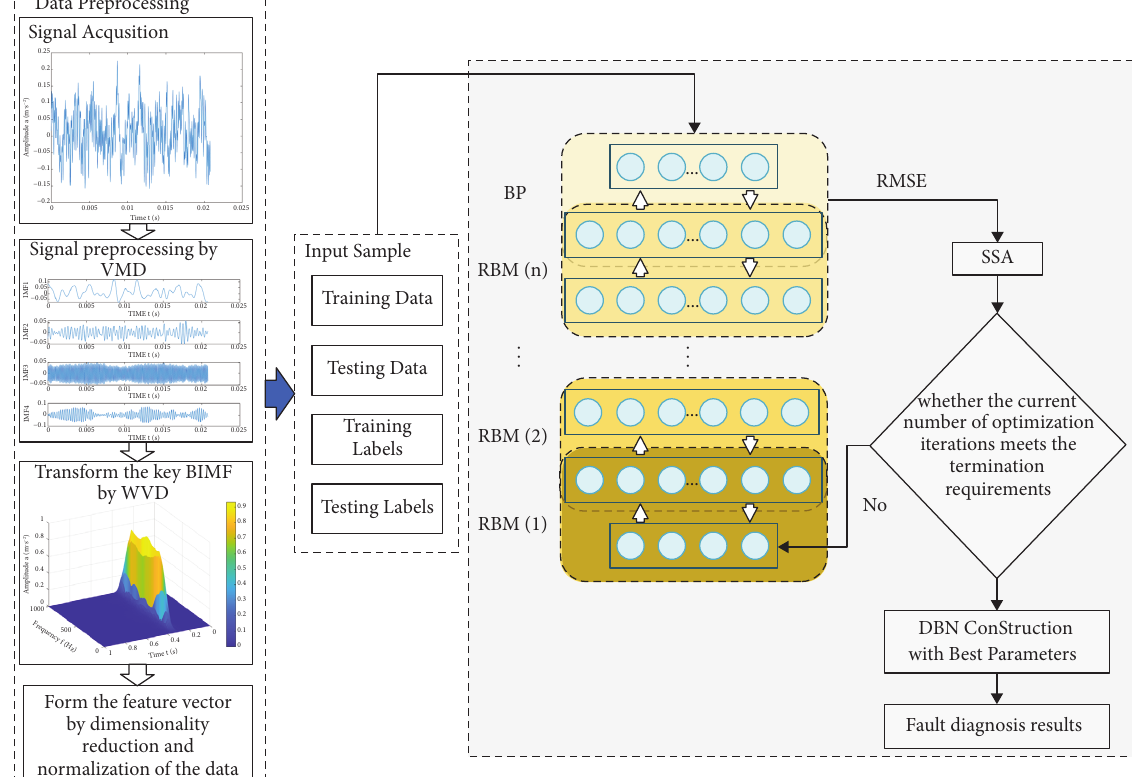
Figure 3: Flow chart of the proposed fault detection model.